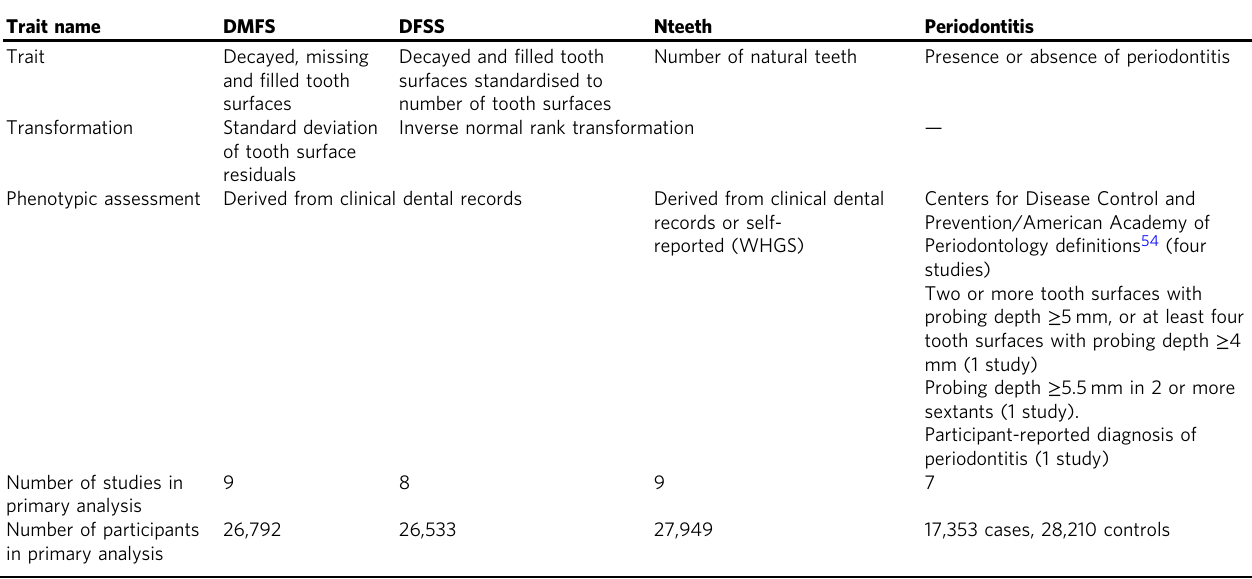
Table 1 Overview of dental disease phenotypes in GLIDE Trait name